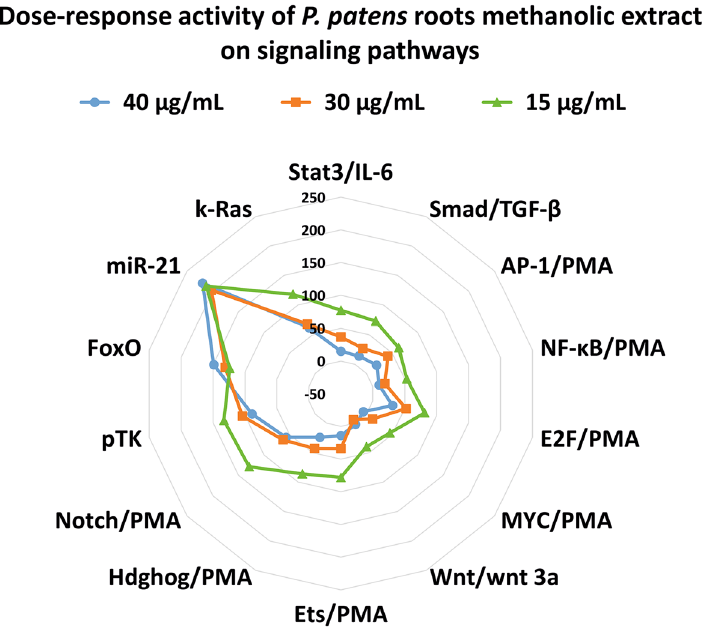
Figure 2. The active compounds from the roots of P. patens against cancer-related signaling pathways in HeLa cells with different concentrations of 40 µg/mL, 30 µg/mL and 15